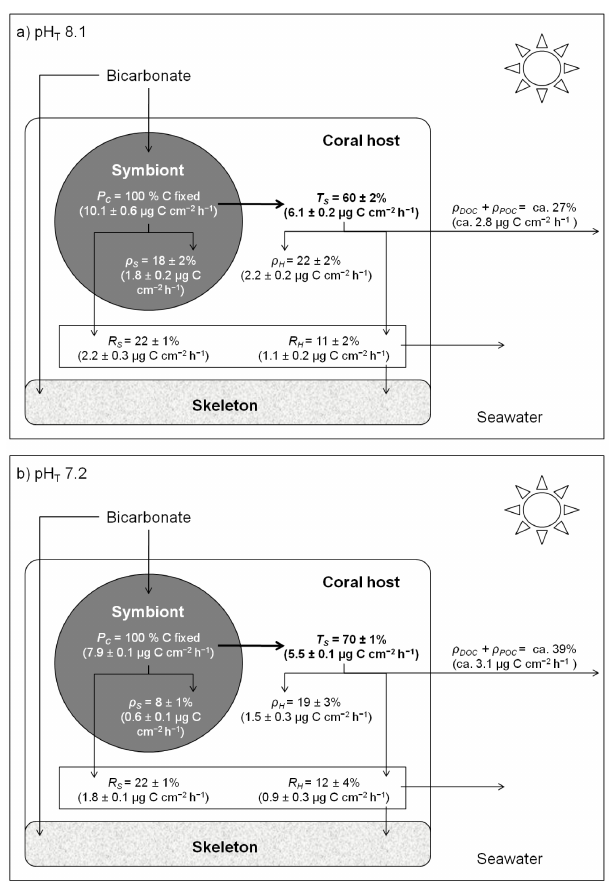
Fig. 5. Mass-balanced results of photosynthate translocation and carbon budget in Stylophora pistillata under (a) pH T 8.1, and (b) pH T 7.2 based on 13 C experiments after 48h. Symbols are defined in the text and summarized in Table 2. Data are means ± standard error of means of n = 3